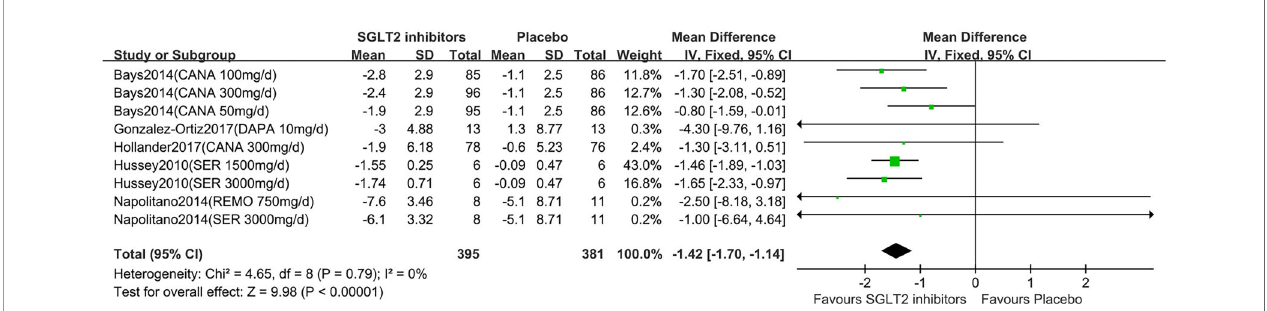
FIGURE 3 | Changes of body weight in patients receiving SGLT2 inhibitors versus placebo. CI, con fi dence interval; IV, inverse variance; SD, standardized